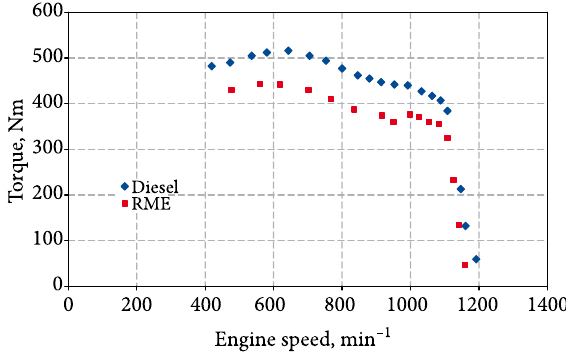
Fig. 2. Comparison of the torque of the engine using pure diesel fuel and pure